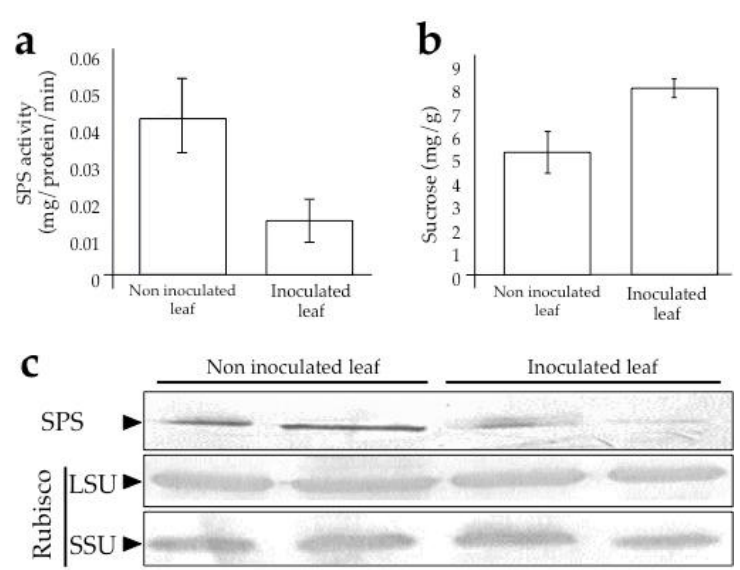
Figure 4. Sucrose phosphate synthase (SPS) activity assay ( a ), sucrose content ( b ), and Western blot on SPS and rubisco protein ( c ) from non-inoculated and inoculated sugarcane leaves. All data are estimated triplicates.